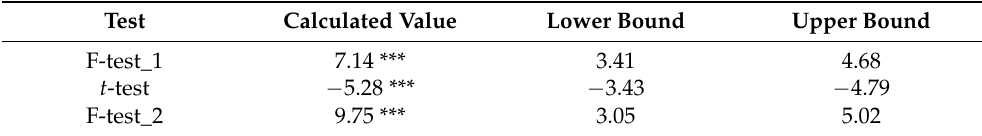
Table 4. AARDL Bounds